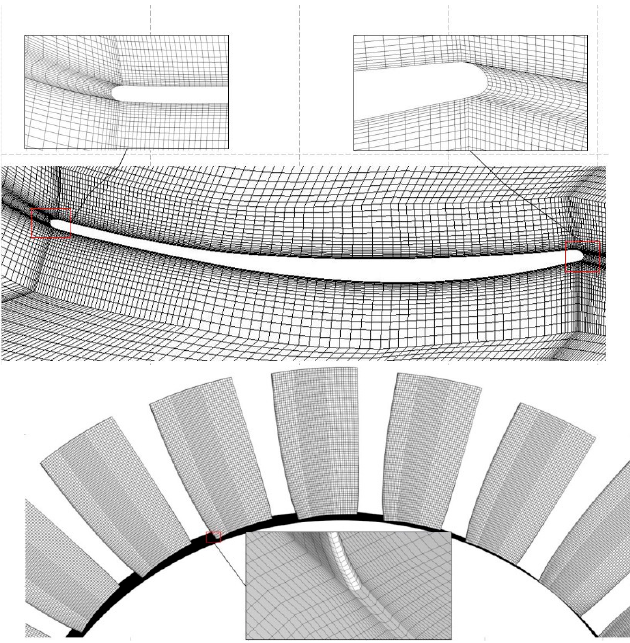
Energies 2018 , 11 , x FOR PEER REVIEW 6 of 19 independence calculation, we obtained the number of elements by varying the number of internal Figure 3. Computational grid around main blade edge and local grid in rotor blade surface. points on the edge of the blades and the maximum size from 10 to 30 mm. In order to eliminate the influence of the number of elements of the mesh on results, this paper selected the grid number of elements of about 3.75 million, 5.87 million, 6.71 million, and 7.28 million to verify the grid independence with MRF technique and moving mesh technique, respectively. As shown in Figure 4a,b, when the grid numbers reach 6.71 million, the numerical results agree well with the experimental results obtained by the fan manufacturer. In the grid